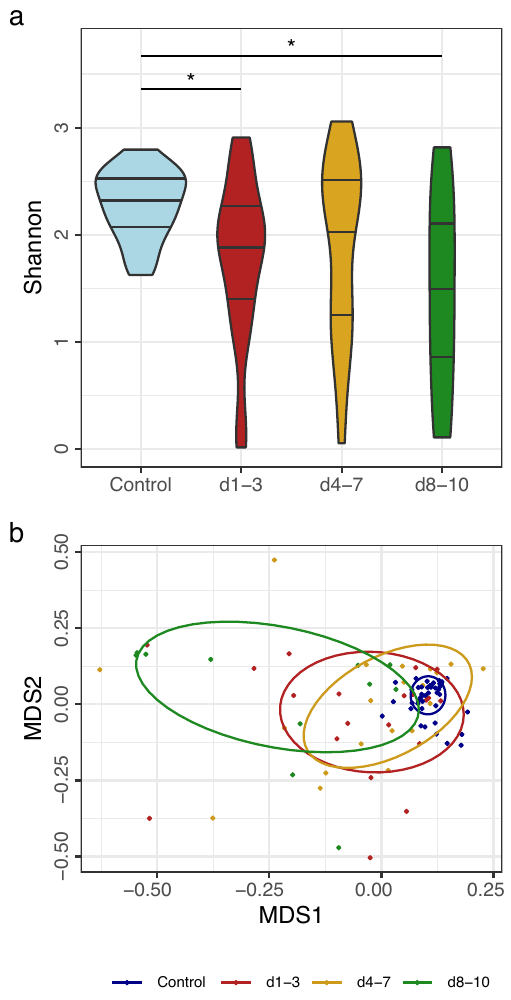
Figure 2. Bacterial diversity, and abundance of beneficial bacteria. ( a ) Shannon diversity of sampling groups, bars indicate 1st 2nd and 3rd quartiles. Due to the broad range of alpha-diversity at day 1–3, day 4–7 and days 8–10, only the median alpha diversity of samples collected at days 8–10 was significantly lower than that of the control group after correcting for multiple comparisons. ( b ) NMDS clustering of beta diversity of bacterial populations compared between sampling groups. PERMANOVA p -value = 0.001. Ellipses indicate 60% similarity. Conover-Iman significance *** p ≤ 0.001, ** p ≤ 0.01, * p ≤ 0.05, p > 0.05 = not